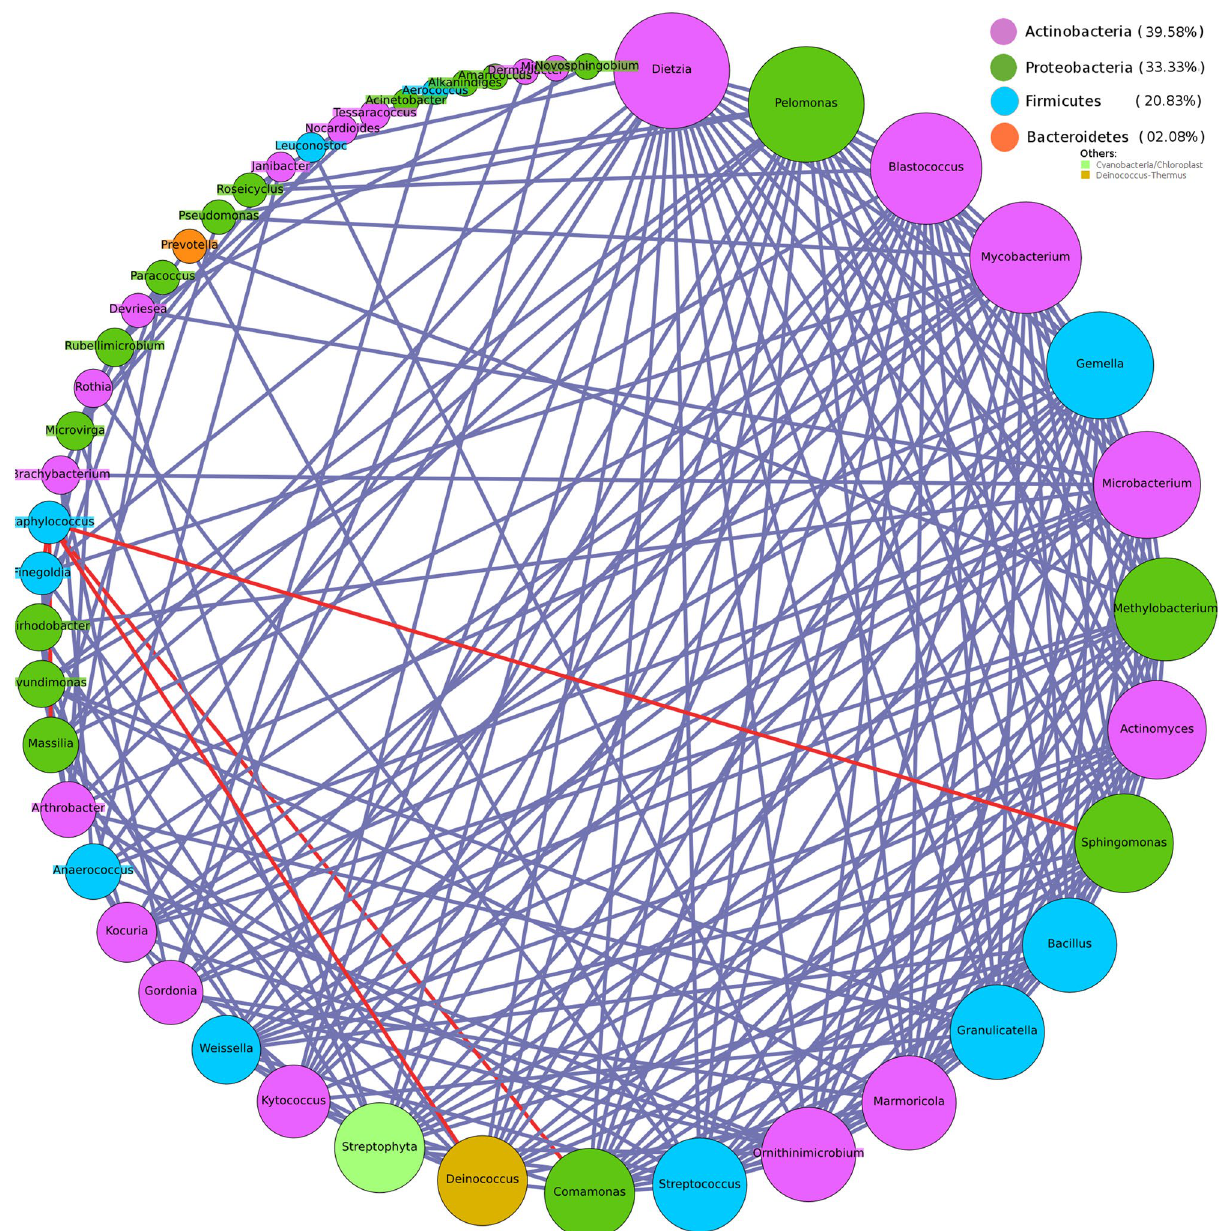
Figure 9. Degree sorted community network structure for samples pertaining to Healthy (control) set from Hyderabad location. Nodes were colored according to their phylum affiliation. Genera belonging to Actinobacteria and Proteobacteria phyla were not only observed to predominate the network in terms of membership but were also observed to be the top degree nodes of the co-occurrence network. Graphs were generated using Gephi v